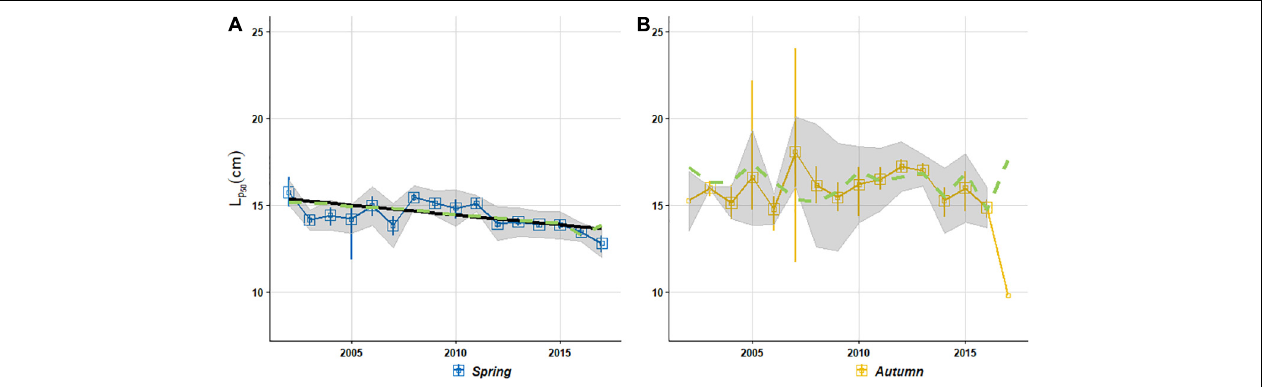
for both spring (A) and autumn (B) spawning season. Vertical bars give the bootstrap 95% confidence limits for all FIGURE 4 | Time series of PMRN midpoints L p 50 → L p cohorts. The gray polygon represents the reaction norm widths (L p ) and indicates the length where the probability of maturing equals 25% and 75% (lower 75 25 and upper part, respectively). Solid lines are regression lines of reaction norm midpoints against cohort, weighted by the inverse of variance estimates from the bootstrap analysis, whenever significant. Dashed lines give the predicted L p from Eq. (8) investigating either long-term trend (only significant for spring PMRN) or 50 short-term fluctuations (only significant for autumn PMRN) and including abundance, environmental effects and cohort for long-term trend